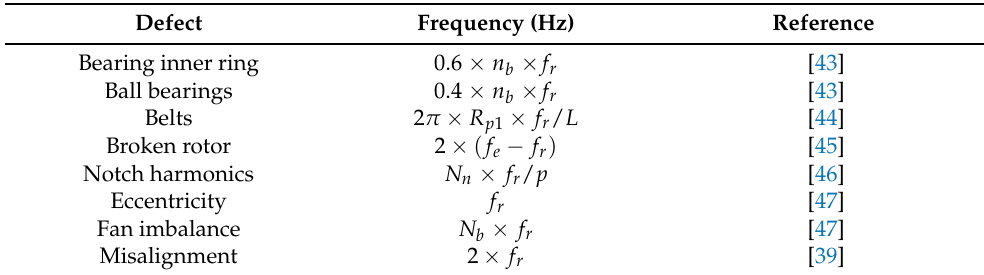
Table 3. Types and defects